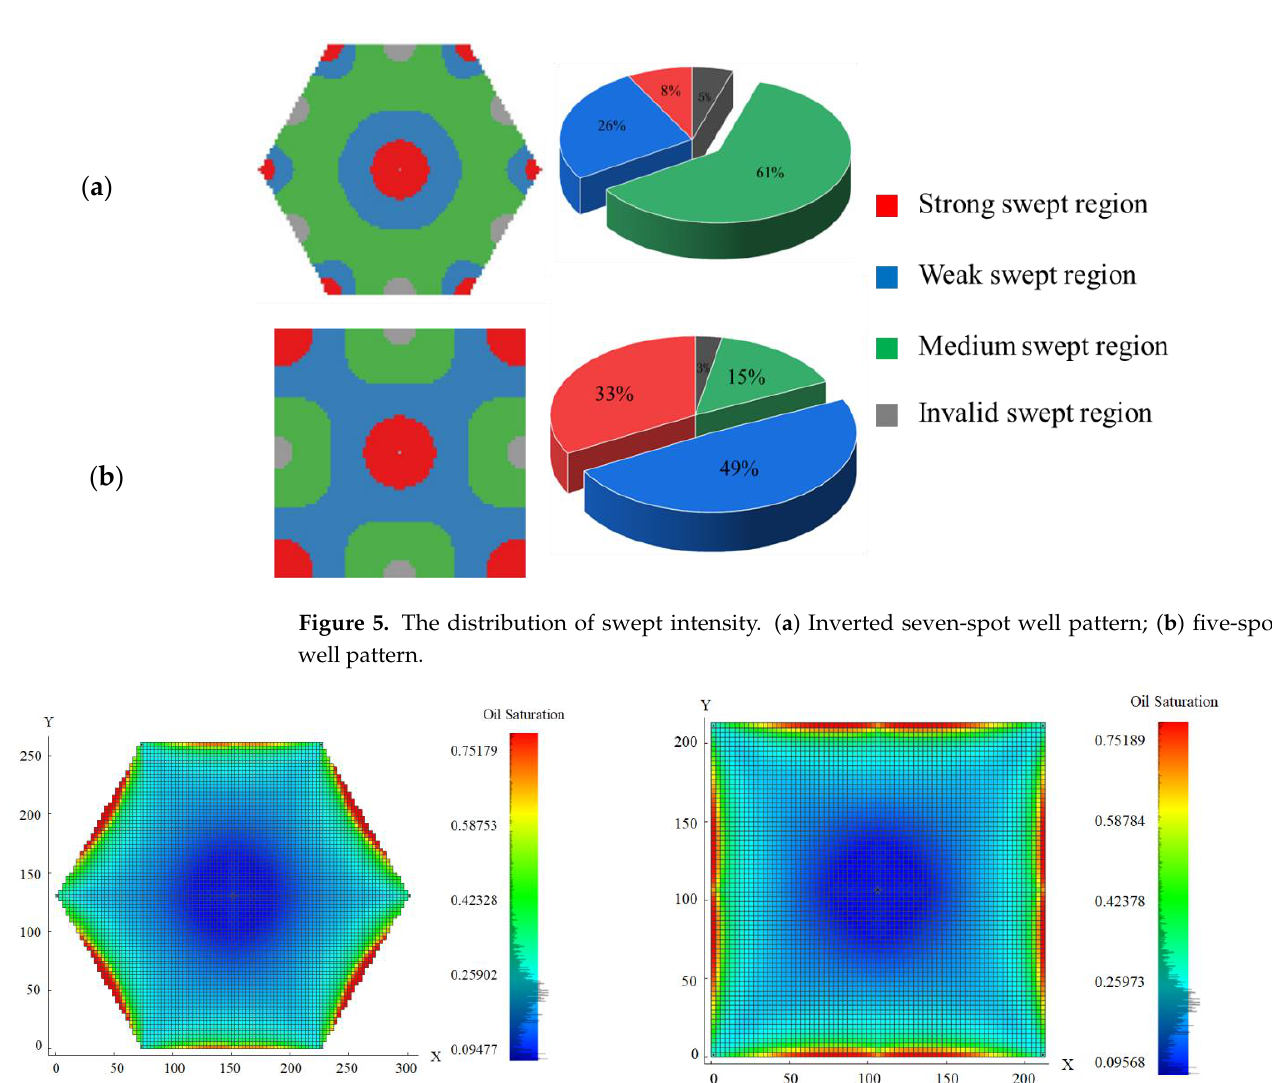
Figure 6. The distribution of oil saturation. ( a ) Inverted seven-spot well pattern; ( b ) five-spot well pattern.